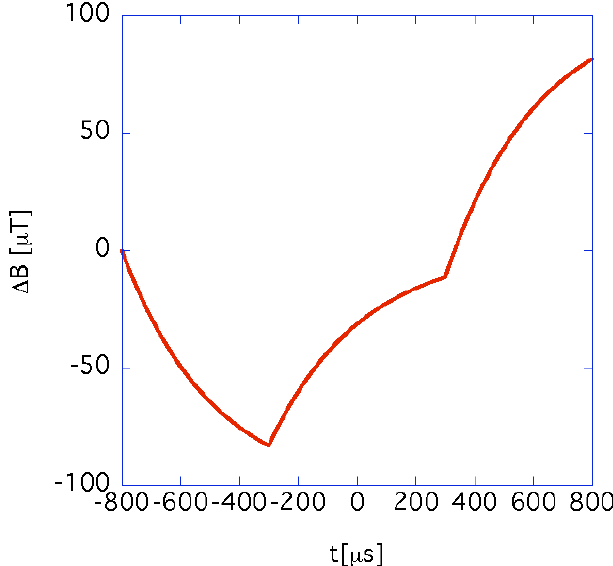
FIG. 19. (Color) The field modulation where the coil in an open space has shorted